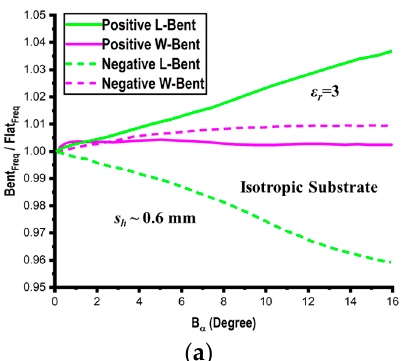
Figure 11. Bending e ff ect on an isotropic substrate with respect to the bending angle ( B α ) ( a ) and substrate height ( s h ) ( b ).